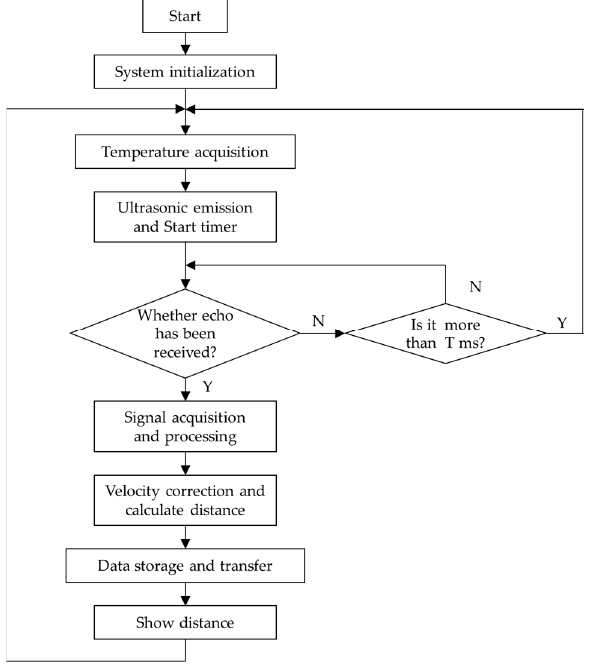
Figure 7. A program flow of an ultrasonic ranging system.